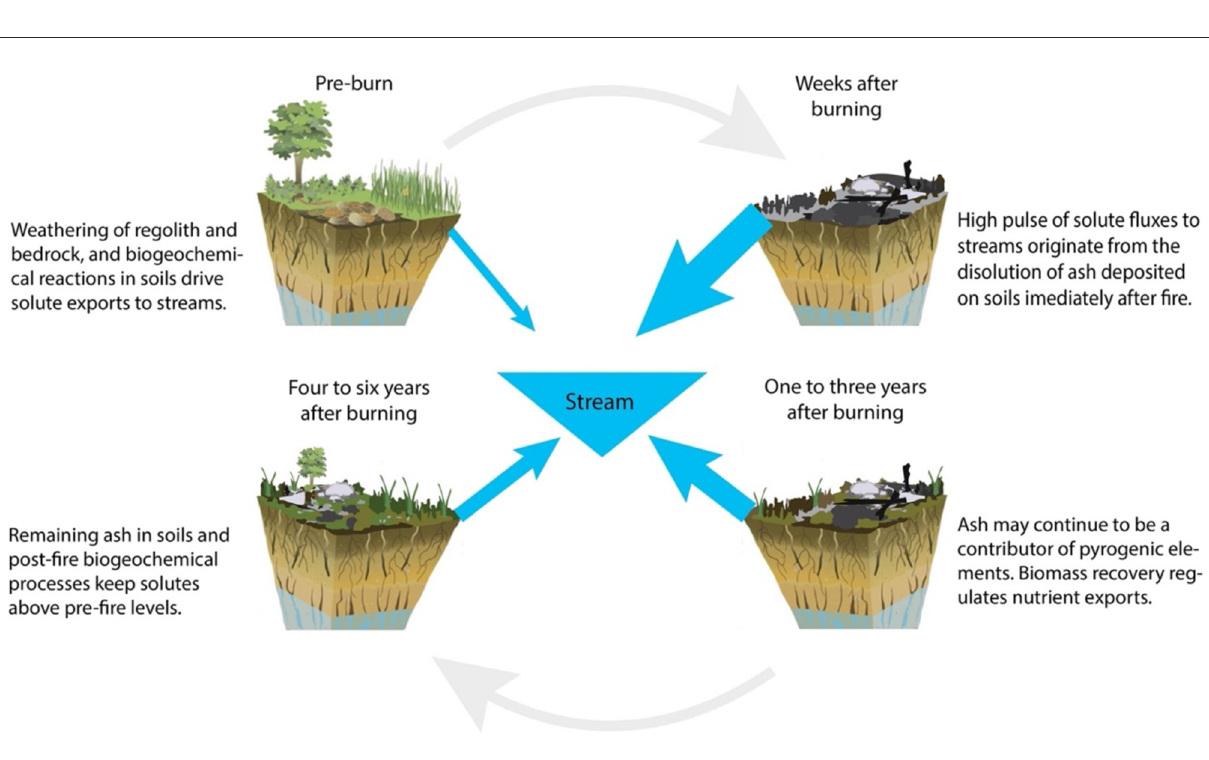
suspended sediments and solutes, their retardation